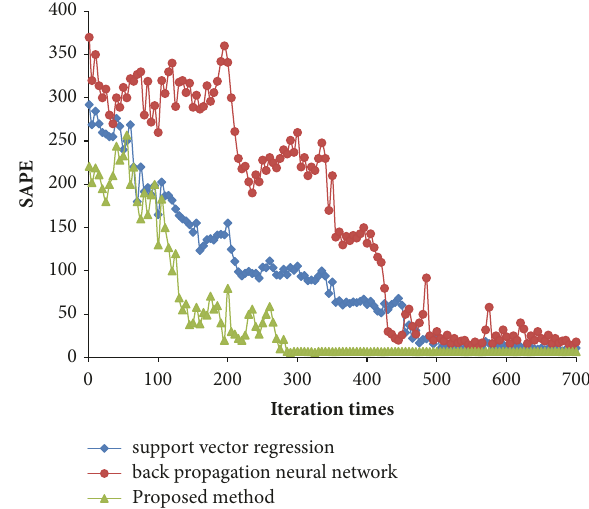
Figure 6: Convergence of lower-phase model based on different